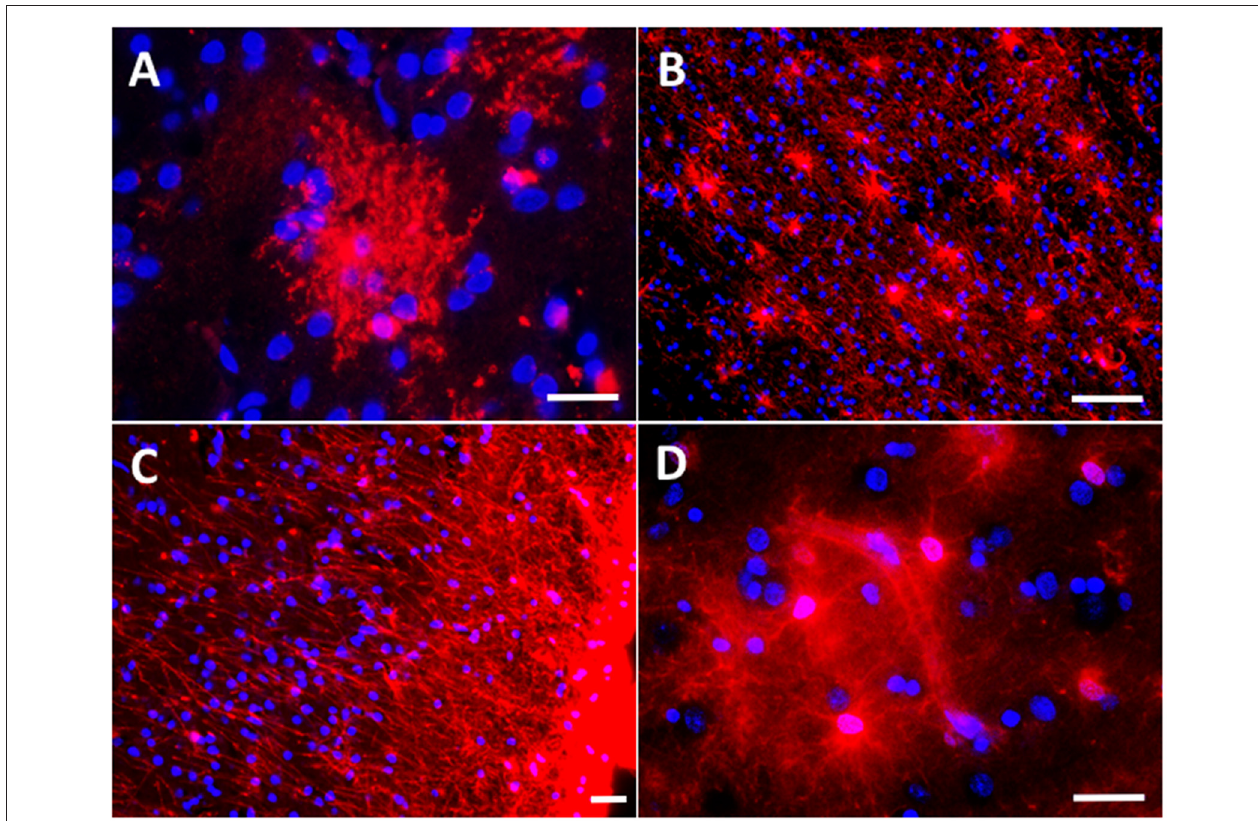
FIGURE 1 | Astrocyte morphological features in the normal brain. (A) Protoplasmic astrocyte in layer II of the occipital neocortex with its typical bushy appearance depicted with immunohistochemistry for the glutamate transporter GLT-1/EAAT2. (B) Fibrous astrocytes in the white matter of the temporal lobe are rich in glial fibrillary acidic protein (GFAP). (C) Subpial interlaminar astrocytes in the frontal association neocortex of a healthy control individual form a palisade of processes which extend towards deep layers perpendicularly to the cortical surface and are GFAP-immunoreactive. (D) Perivascular astrocytes with their vascular endfeet wrapping a capillary vessel, here shown with immunohistochemistry for aldehyde dehydrogenase 1 L1 (constitutively present in all astrocytes). Scale bars: 10 µ m in (A,C,D) ; 20 µ m in (B) .